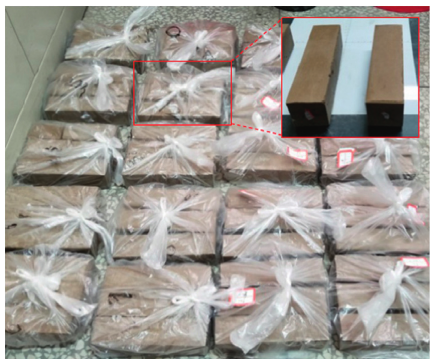
Figure 3: Specimens covered by plastic